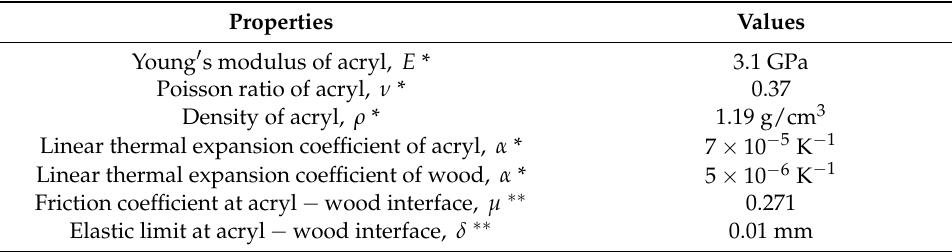
Table 1. List of thermoelastic properties of the acryl and the acryl-wood